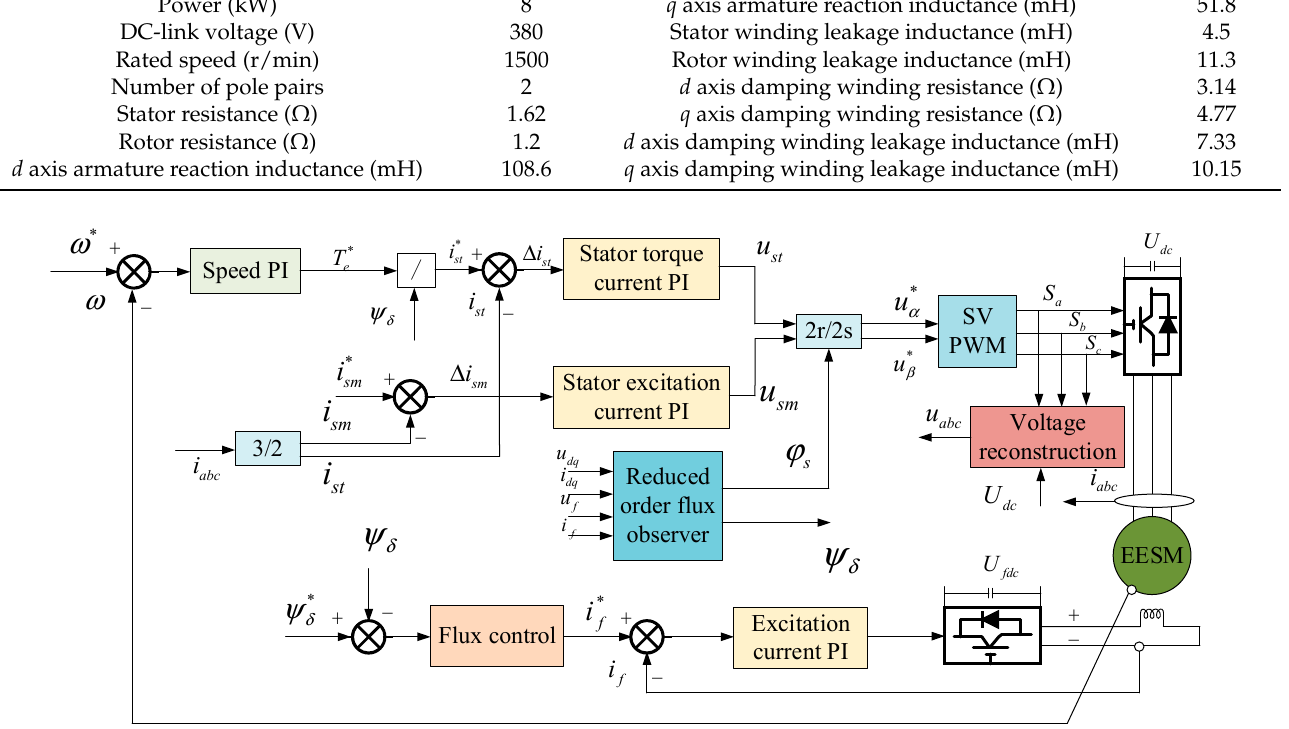
Table 3. EESM parameters.